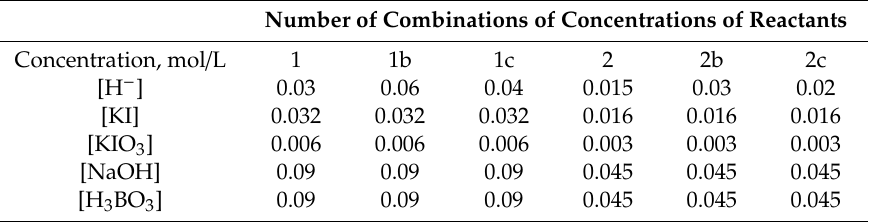
Table 2. Possible combinations of reagent concentrations for use in the experimental determination of the quality of micro-mixing in microreactors